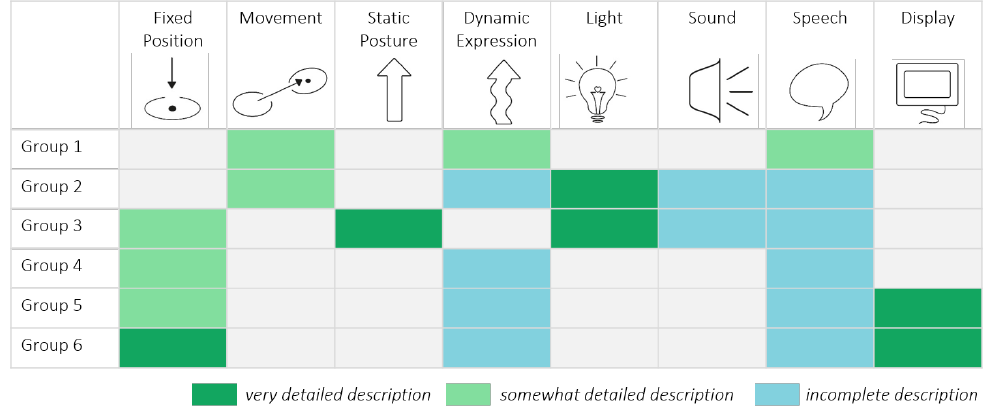
Figure 9. Overview of communication modalities used by the groups to create multi-modal behaviors for the negative feedback